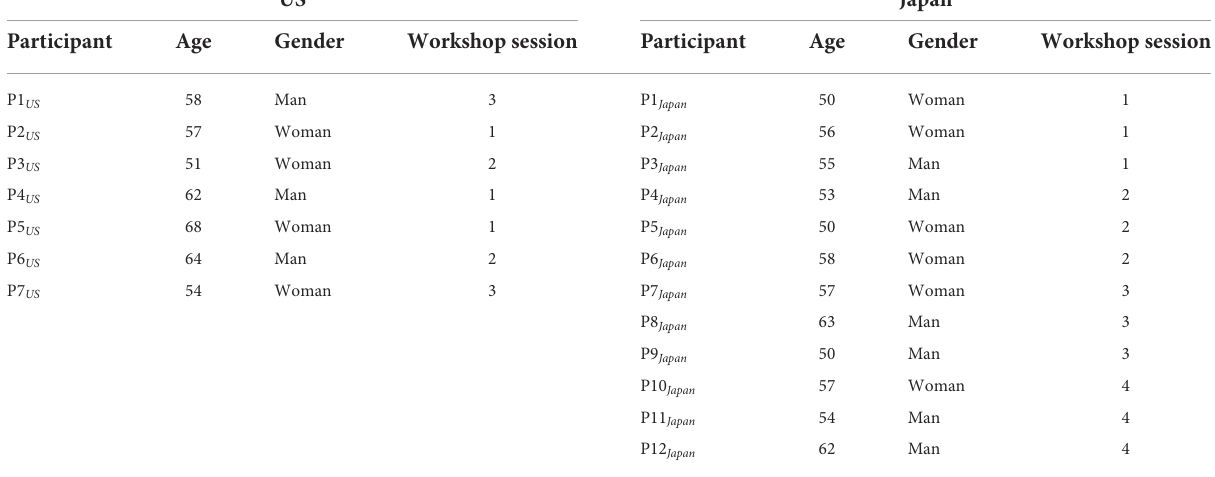
TABLE 1 Demographic information of the participants (P# country ).